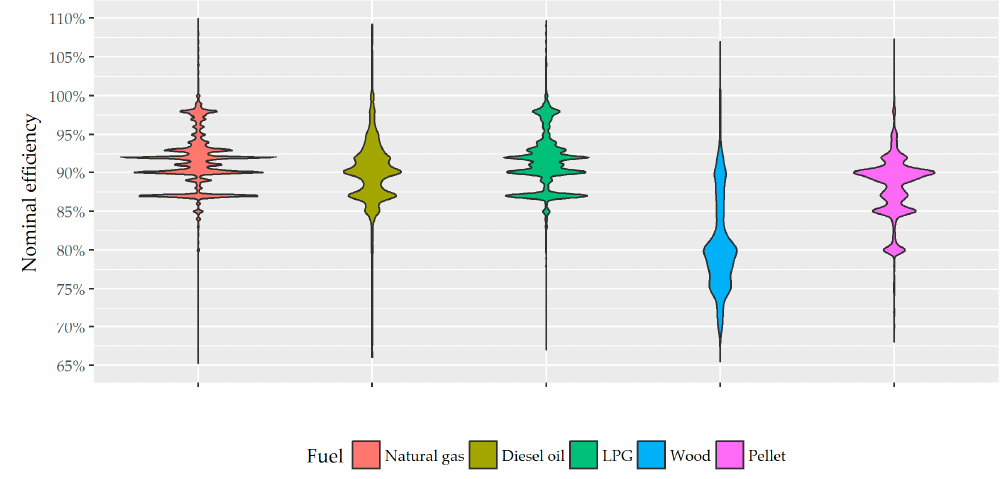
Figure 4. Nominal efficiency for boilers supplied by different fuels.